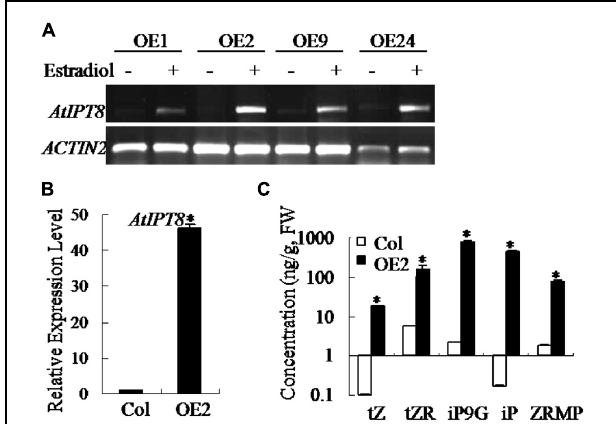
FIGURE 1 | Overexpression of AtIPT8 promoted overproduction of endogenous cytokinins in Arabidopsis . Asterisk symbols ( ∗ ) indicate p < 0.05 (Student t- test). (A) Semi-quantitative RT-PCR to examine the expression levels of AtIPT8 in independent 17- β -estradiol-inducible transgenic lines. Overexpressing AtIPT8 transgenic lines ( OE1 , OE2 , OE9, and OE24 ) showed higher expression levels of AtIPT8 in an estradiol-dependent manner. ACTIN2 was used as the internal control. Estradiol: 17- β -estradiol (10 μ M). (B) The AtIPT8 expression level was more than 40-fold higher in OE2 plants after 10 μ M 17- β -estradiol treatment for 24 h. The values of Y -axis indicate means ± SE (standard errors) of three independent experimental repeats. (C) The cytokinin varieties in the 2-week-old seedlings of Col and OE2 were quantified using GC-MS. Seedlings of OE2 were pre-treated with 10 μ M 17- β -estradiol for 24 h. The data represent the means ± SE of two reproducible experiments (fresh weight, FW).